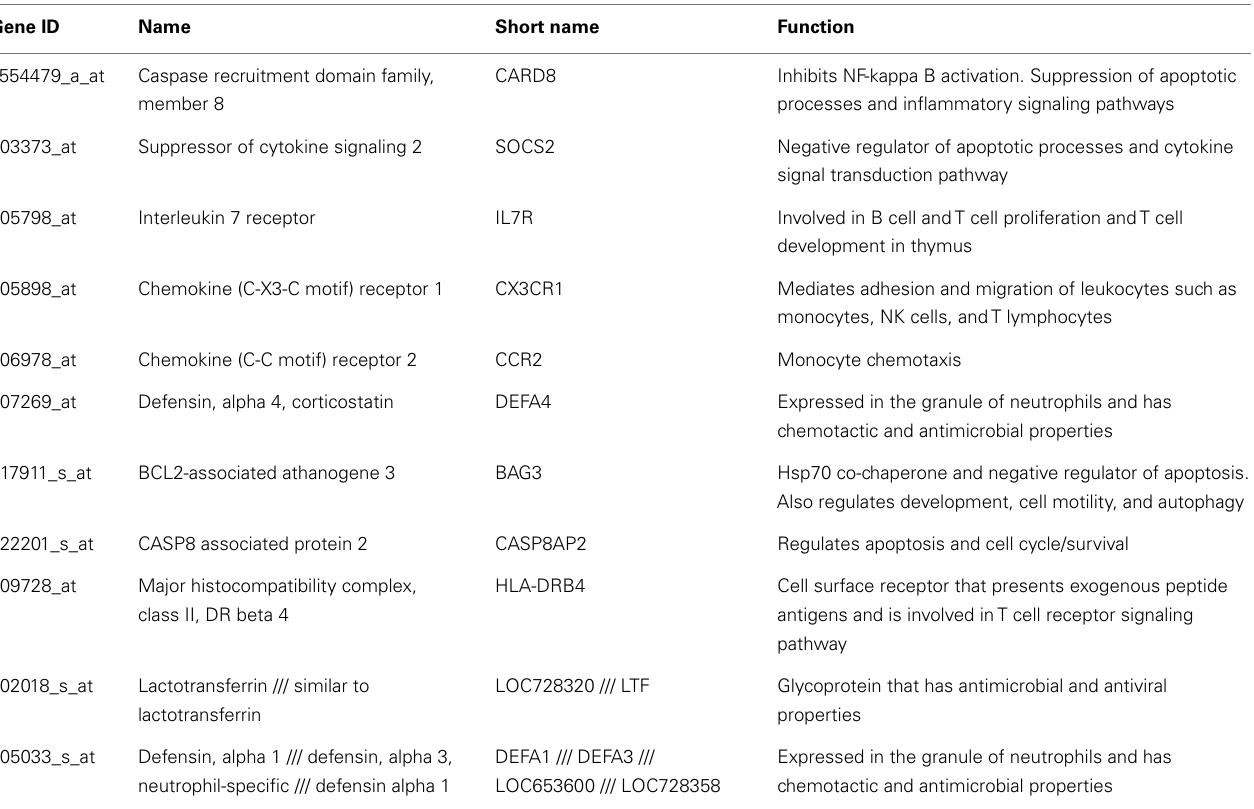
TableA1 | Genes down regulated in all HCV subjects compared to normal